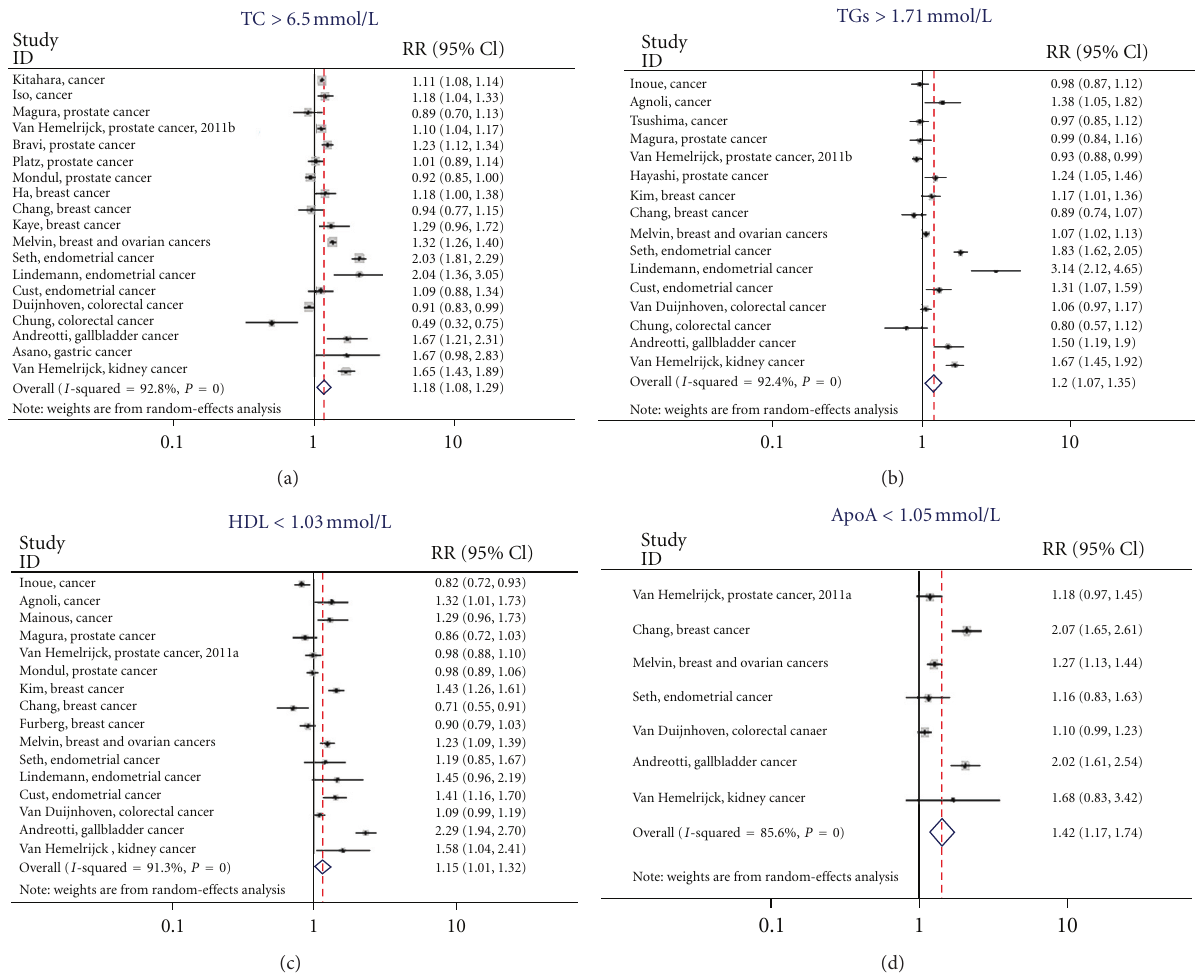
desity Lipoprotein; apolipoprotein